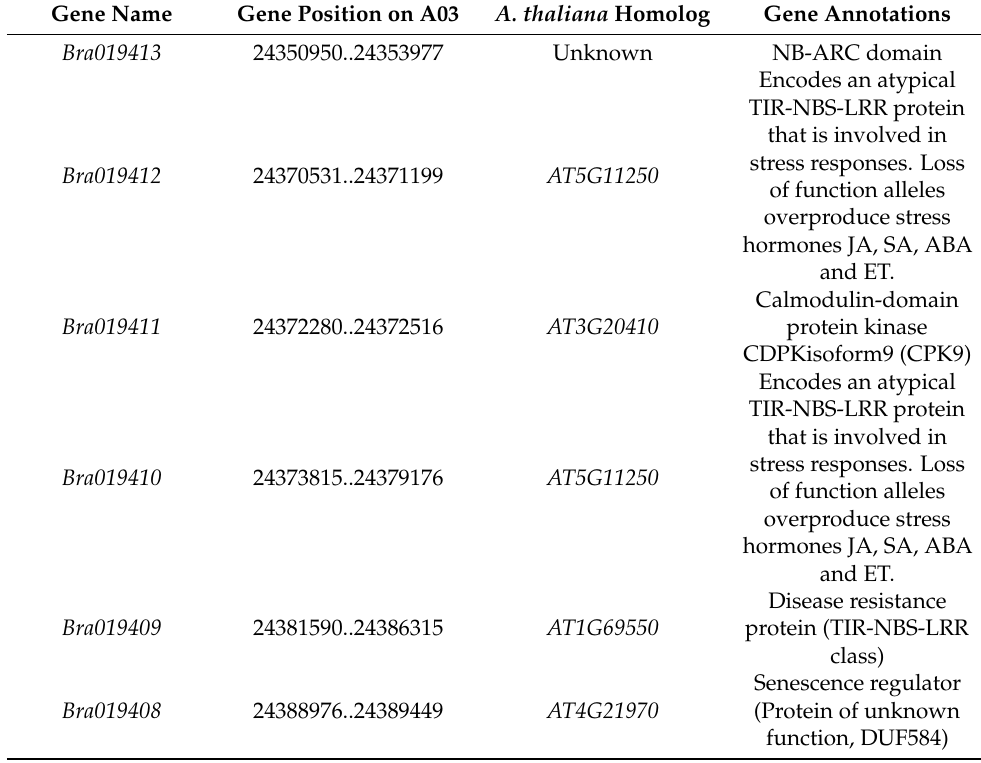
Table 2. Annotated genes in the candidate region of CRq